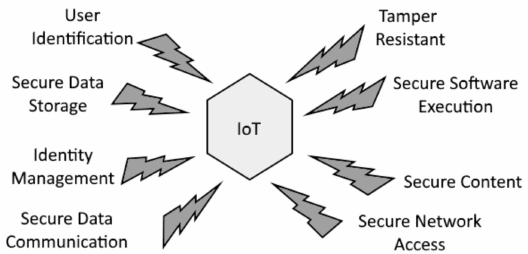
Figure 4. Major security concern for Internet of Things (IoT)